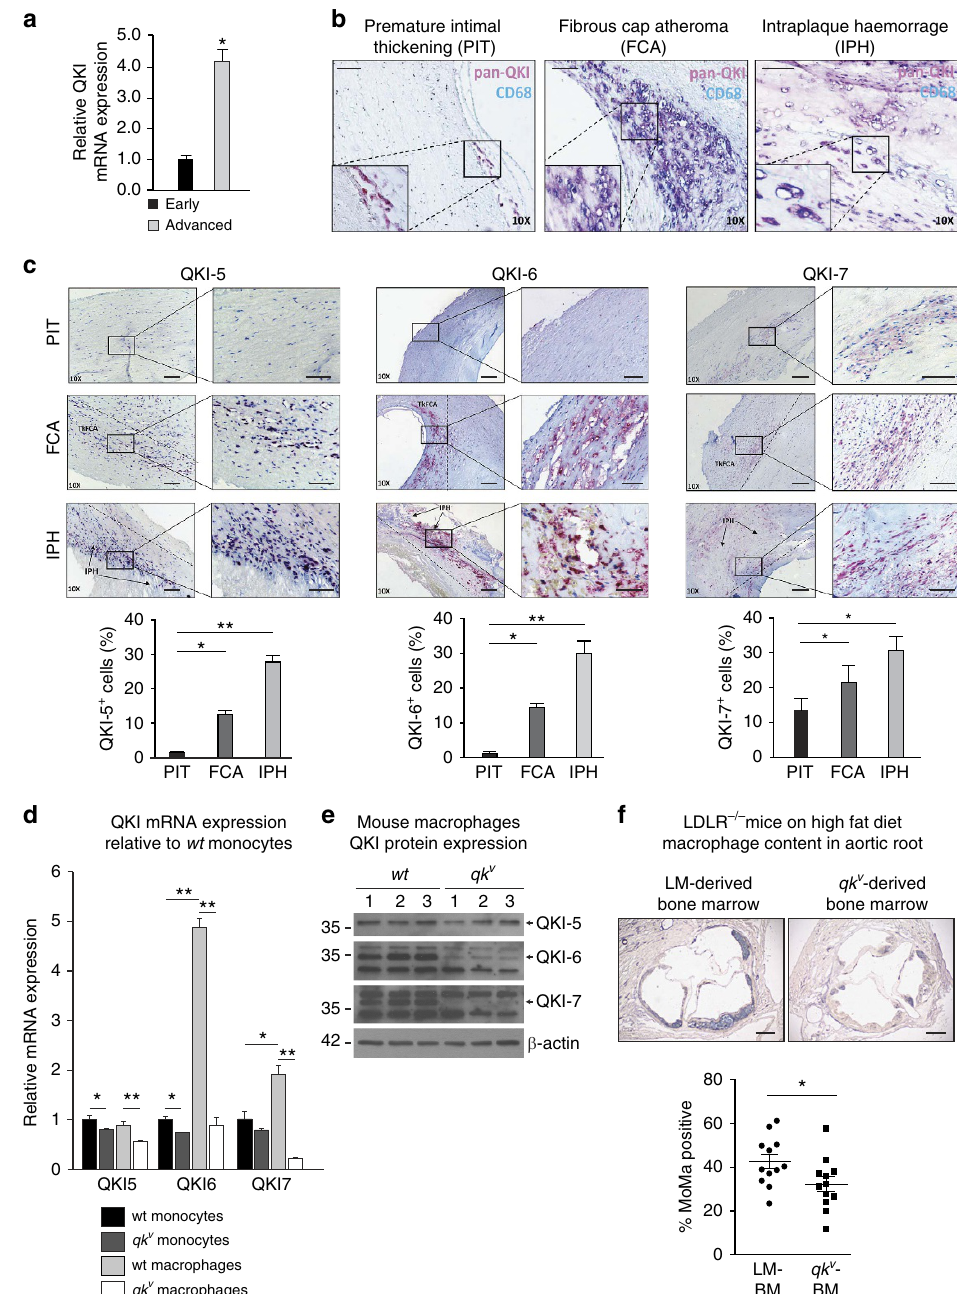
Figure 1 | Quaking is expressed in macrophages within atherosclerotic lesions. ( a ) Pan-QKI mRNA expression levels in CD68 þ macrophages of early and advanced atherosclerotic lesions isolated by laser-capture microdissection ( n ¼ 4). Data expressed as mean ± s.e.m.; Student’s t -test, * P o 0.05. Scale bar, 50 m m. ( b ) Immunohistochemical analysis of co-localization of pan-QKI and CD68 expression in preliminary intimal thickening (PIT), FCA and intraplaque haemorrage (PIH). Dashed line denotes intimal/adventitial border. Scale bar, 50 m m. ( c ) Immunohistochemical analysis of QKI-5, -6 and -7 expression in PIT, FCA and IPH (top), and quantification of QKI-positive cells mm 2 per tissue sample ( n ¼ 5). Data expressed as mean ± s.e.m.; one-way analysis of variance (ANOVA), Bonferroni’s post-hoc test; * P o 0.05, ** P o 0.01. ( d ) Quantitative RT–PCR (qRT–PCR) analysis of QKI mRNA expression in naive BM-derived CD115 þ mouse monocytes and 7 days M-CSF stimulated macrophages of either wt -littermates (LM) or quaking viable ( qk v ) mice ( n ¼ at least 3 mice per condition). Data expressed as mean ± s.e.m.; one-way ANOVA, Bonferroni’s post-hoc test; * P o 0.05 and ** P o 0.01. ( e ) Western blot analysis of QKI-5, -6 and -7 expression levels in 7 days M-CSF stimulated macrophages derived from BM of wt and qk v mice. Each lane represents an individual mouse lysate (biological n ¼ 3). ( f ) Immunohistochemical analysis for atherosclerotic plaque-resident macrophages (% MoMa-positive area) in aortic root sections of g -irradiated (8Gy) LDLR (cid:2) / (cid:2) mice that subsequently were transplanted with BM from either qk v mice ( qk v -BM) or littermates (LM)(LM-BM) and fed a high-fat diet for 8 weeks to develop atherosclerotic lesions ( n ¼ 12 per group). Scale bar, 200 m m. Data expressed as mean ± s.e.m.; Student’s t -test, with * P o 0.05.